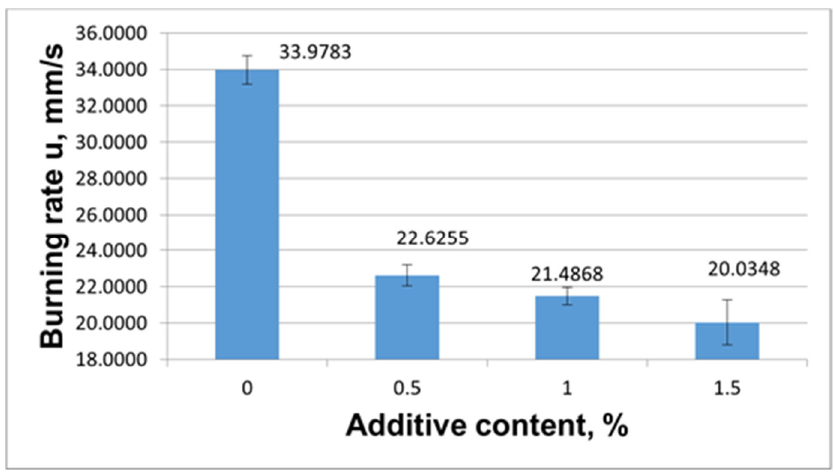
Figure 8. Effect of modifier 8 on the change in the burning rate of KNO 3 /Zr.